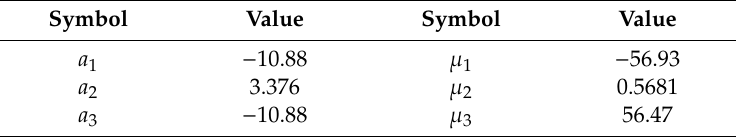
Table 2. Curve fitting results for Ogden’s incompressible model. Figure 4. Comparison of tensile test results and Ogden’s incompressible model.